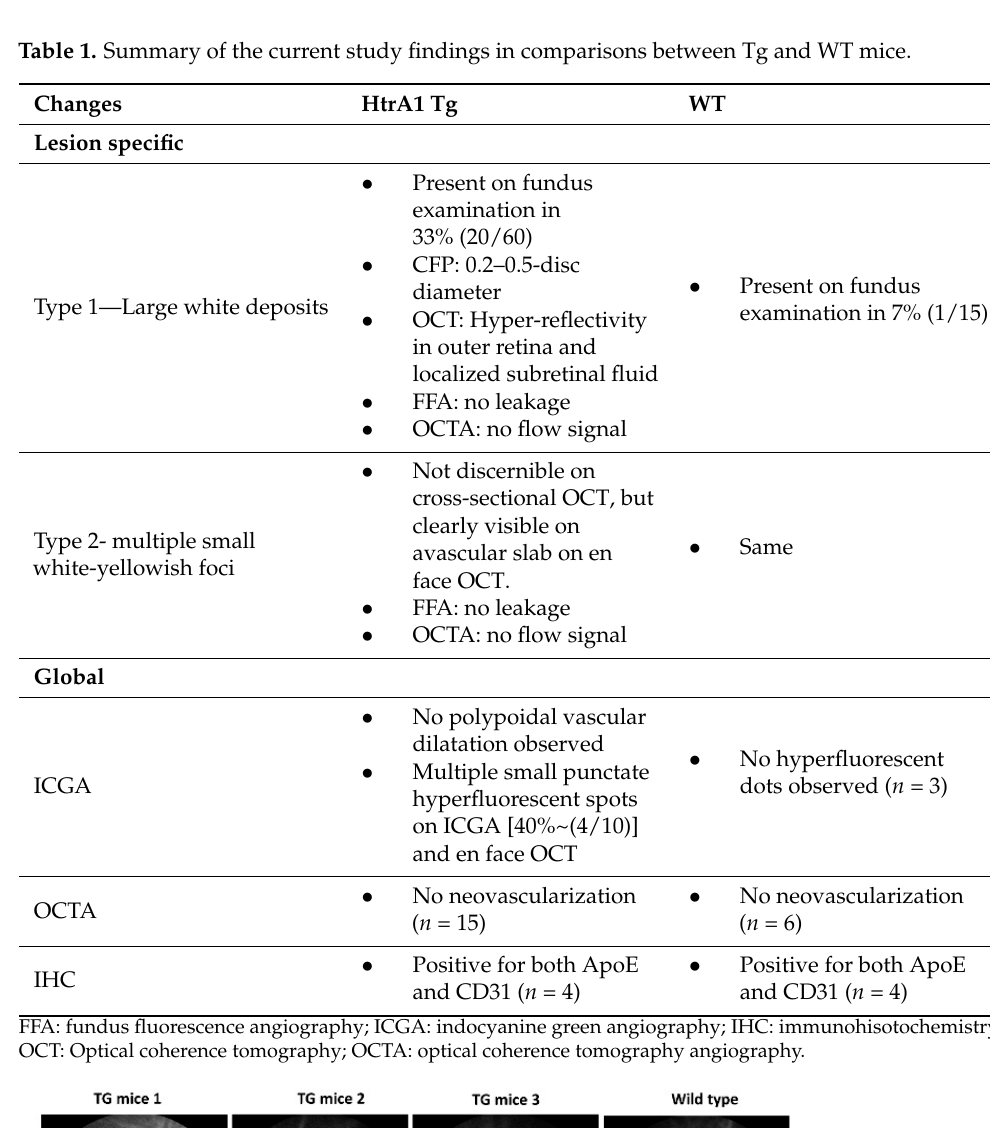
Table 1. Summary of the current study findings in comparisons between Tg and WT mice.